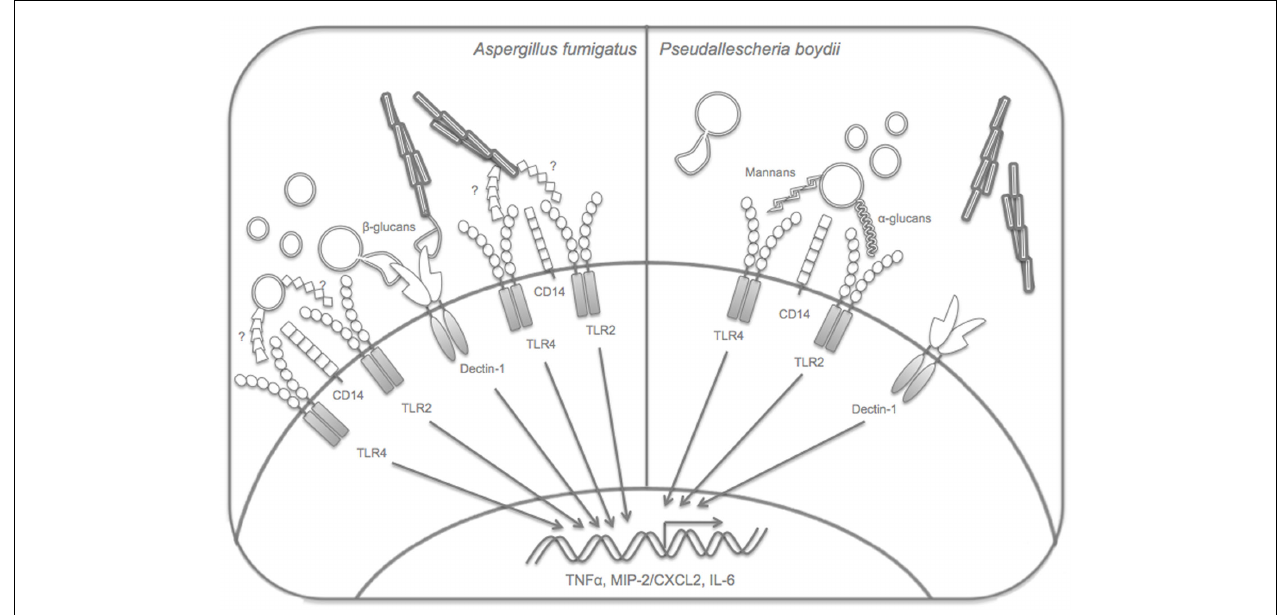
release by innate immune cells. Recognition of P. boydii involves recognition of α -glucans and rhamnomannans byTLR2 andTLR4, respectively. P. boydii conidia require CD14 andTLR4 activation for the induction of macrophage activation, while activation ofTLR2 orTLR4 is dispensable for macrophage recognition by P. boydii hyphae.The role of Dectin-1 in P. boydii recognition is still